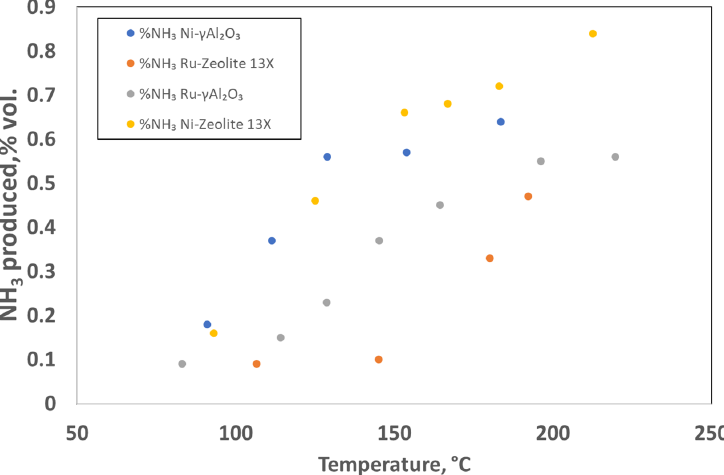
Figure 9. Results of the NTP-assisted catalytic activity tests. Operating conditions: space velocity of 0.5 L (g cat h) − 1 and atmospheric pressure, feed rate N 2 :H 2 = 1:3 and the power of the electric field was varied from 11 W to 66 W.